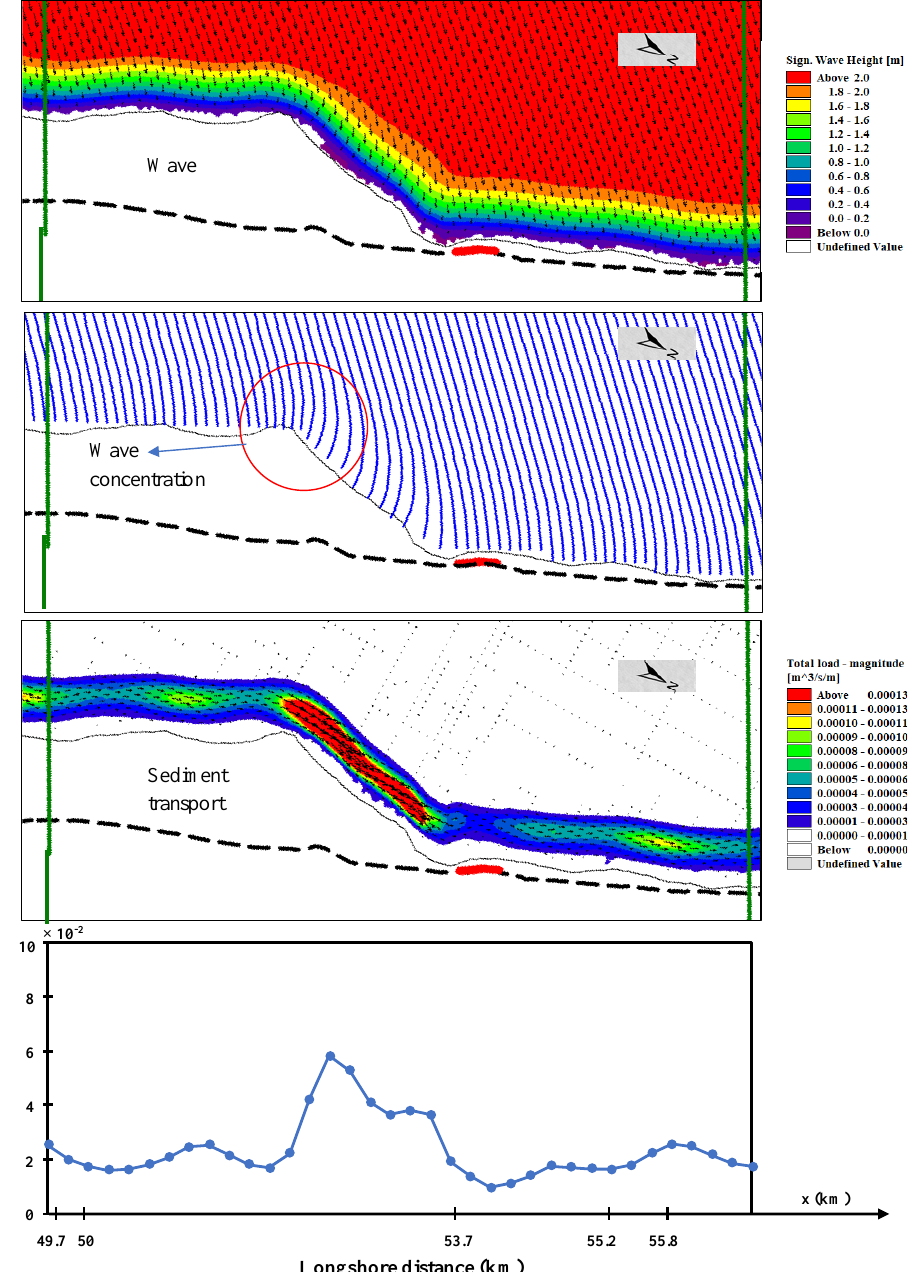
Figure 22. Snapshots of the wave field, wave ray, sediment transport field and the distribution of alongshore sediment transport flux during a high energy event on 3 July 2007 (H = 2.4 m, T = 8.1 s, and θ = 218.6°) around the high-amplitude spit. The arrow indicates the resultant direction of wave and sediment transport. The red circle indicates wave concentration around the spit. The dotted line indicates Marine Drive Road. Red line represents the revetment.